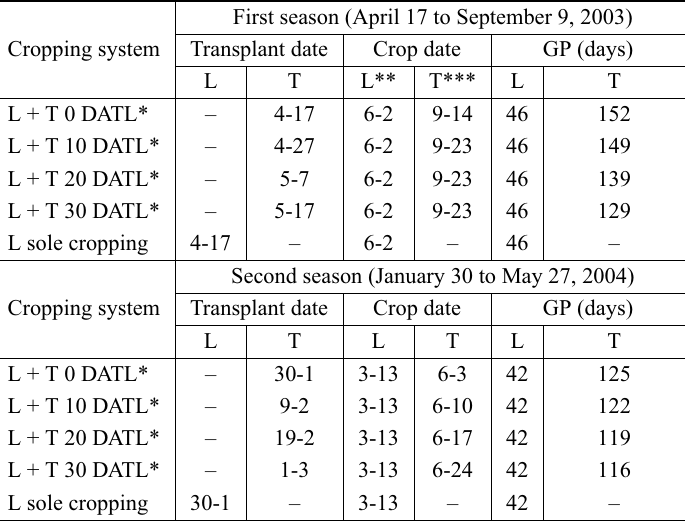
Transplanting, harvesting, and growth periods (GP) of lettuce (L) and tomato (T) of experiments 3 and 4, characterized by the transplanting of tomato after lettuce, in two cropping seasons.